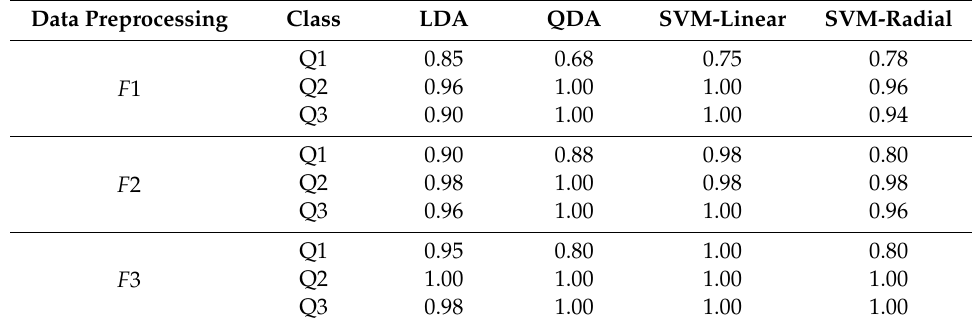
Table 4. Specificity values (i.e., true negative rate) achieved for the external validation dataset (testing dataset), per grouping